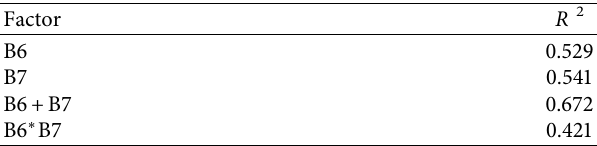
Table 5: Correlation index between NH